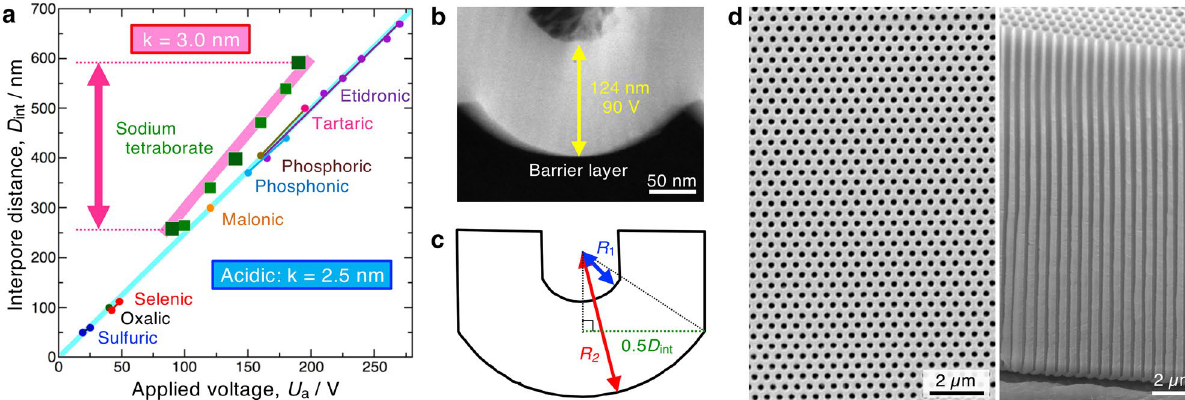
Figure 2. Ideally ordered porous AAO structures fabricated under a new regime in an alkaline electrolyte. ( a ) Linear relationships between the applied voltage, U a , and the interpore distance of the self-ordered porous AAO structure, D int , formed by anodizing in conventional acidic electrolyte solutions, including sulfuric, oxalic, selenic, malonic, phosphonic, phosphoric, tartaric, and etidronic acids, with a proportional constant of k = 2.5 nm V −1 and in an alkaline electrolyte solution, sodium tetraborate, with k = 3.0 nm V −1 . ( b ) An HAADF- STEM image of the ultrathin section of the bottom barrier layer formed by anodizing at 90 V. A larger anodizing ratio ( δ b / U a ) measuring 1.38 nm V −1 was obtained by an alkaline anodizing process. ( c ) A schematic diagram of the bottom barrier layer with geometrical parameters of D int , R 1 , and R 2 . ( d ) SEM images of the surface